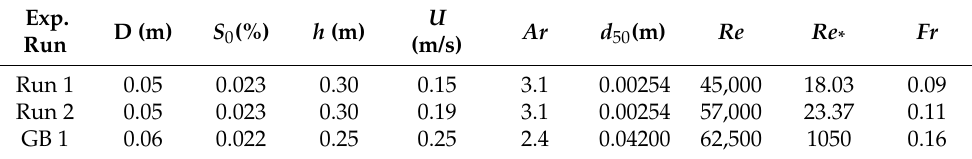
Table 1. Hydraulic and physical parameters of all experimental runs (Run 1, Run 2, and GB 1).